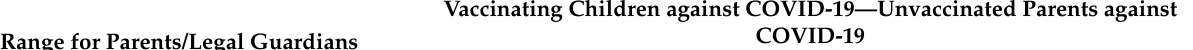
Table 9. Readiness of unvaccinated parents against COVID-19 for vaccination of